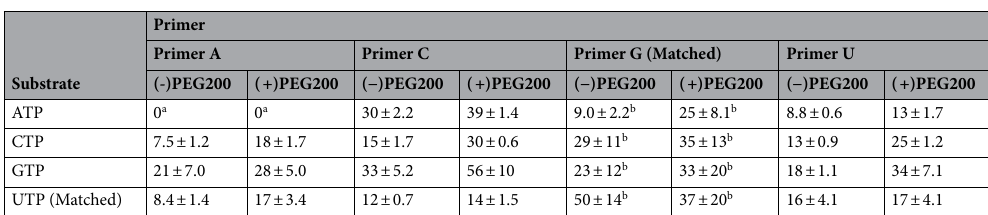
Table 2. Percentages of extended primers with NTPs at the first position next to the 3 ′ terminal of each primer in 0 or 20 wt% PEG200. a No bands for extended primers were detectable. b Data were taken from the reference 26